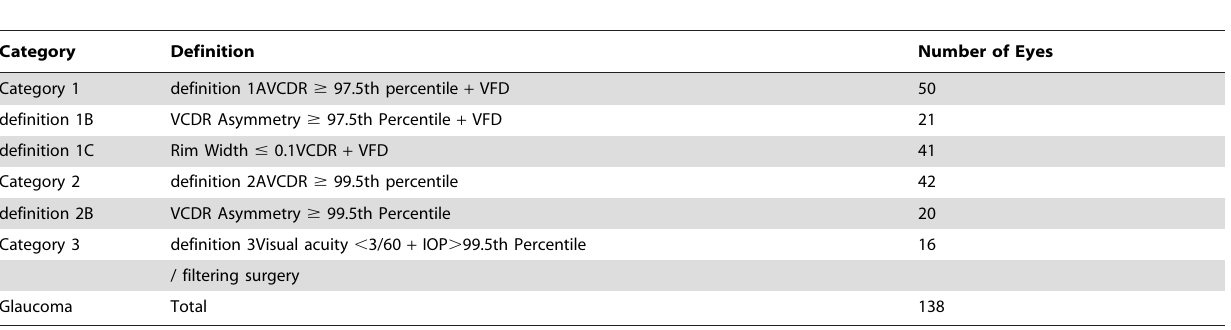
Table 4. Definition of Glaucoma by the International Society of Geographical and Epidemiological Ophthalmology (ISGEO) and the Number of Subjects of the Beijing Eye Study in Each Category.